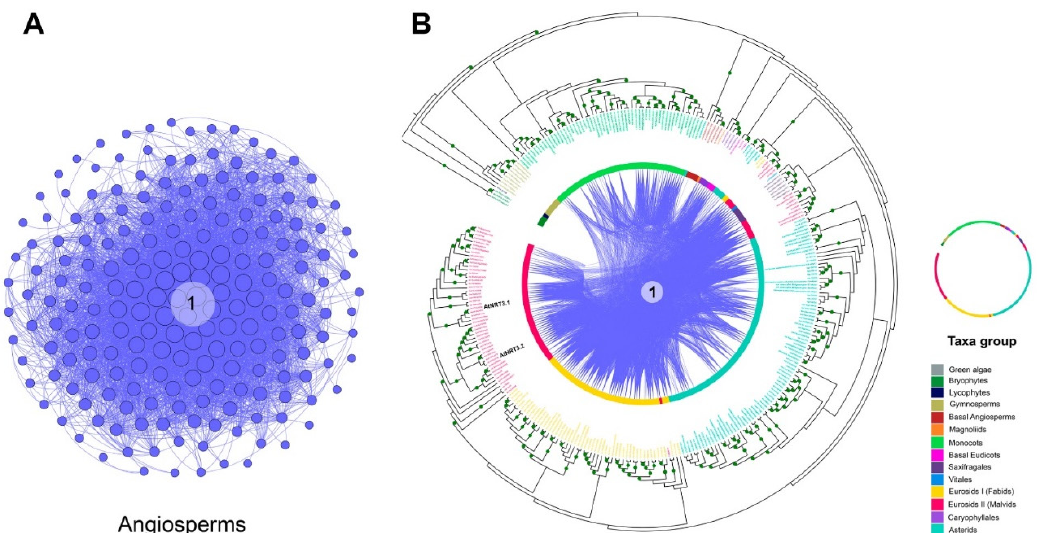
Figure 6. Analysis of the microsyntenic and phylogenomic network of NRT3 genes in taxonomic groups. ( A ) Network of NRT3 genes from the only community in which synteny relationships were determined. ( B ) Circular phylogenetic tree. From the outside to the center: tree of maximum circular likelihood of the NRT3 genes in which syntenic relationships were detected. The intermediate ring represents the different taxonomic groups where the genes present are represented with different colors. Concentric lines represent the connections of each gene pair using curved lines. The image depicts the location of some A. thaliana genes.